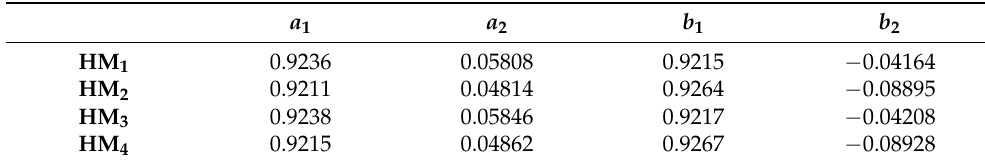
Table 2. The coefficients of the efficiency characteristic